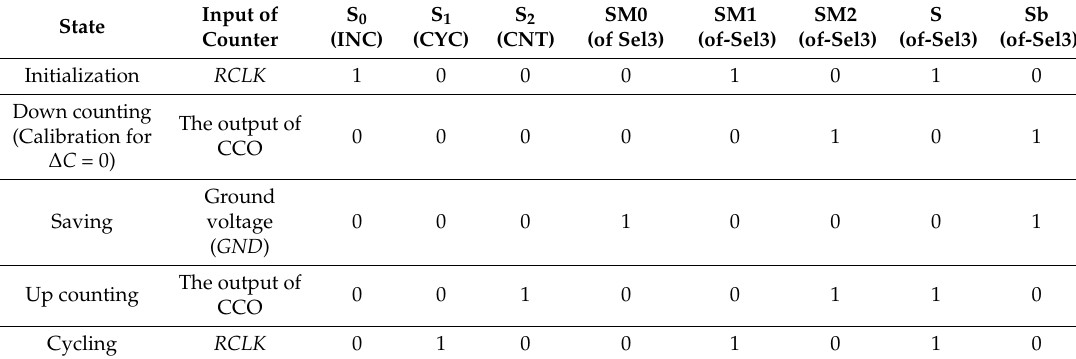
Table 2. Five phases of the sensor and the related situations of the controlling